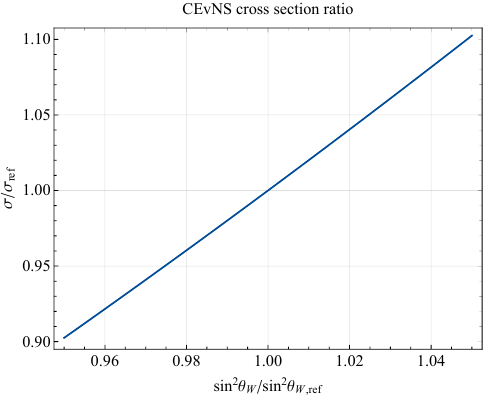
Figure 1 . Relative variation of the CEvNS cross section as a function of a change in the weak mixing angle sin 2 θ W . The reference value of the CEvNS cross section σ ref is obtained with sin 2 θ W, ref = 0 . 238